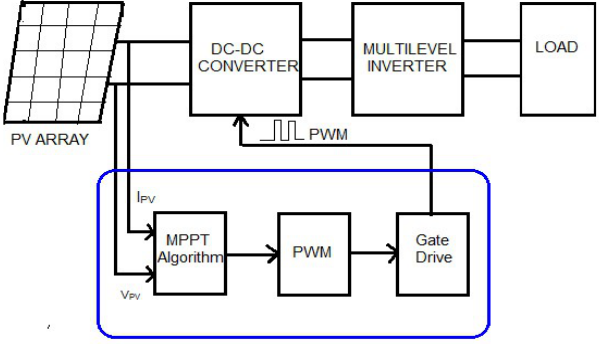
Figure 3. Block diagram of the PV